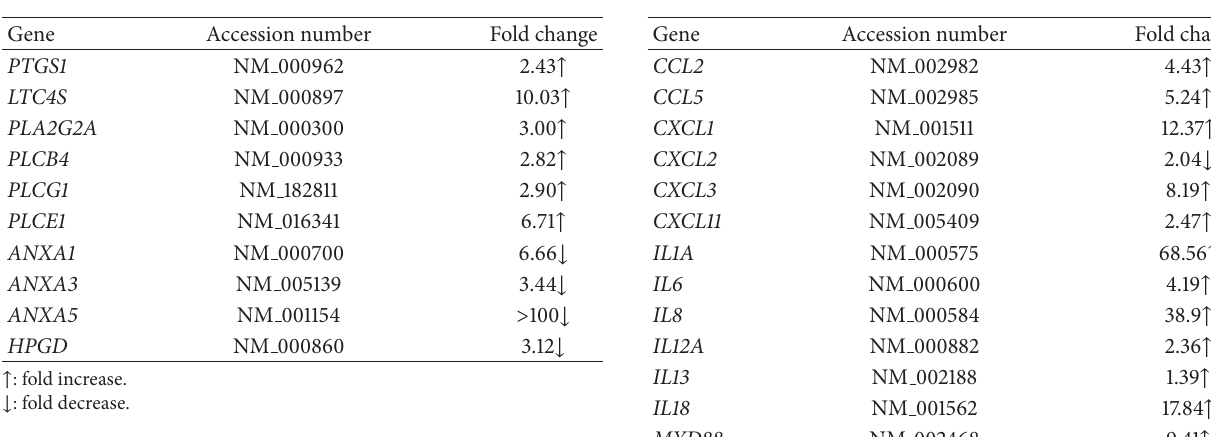
Table 1: Components of eicosanoid signalling regulated by SF in the Taqman 96-well plate array. Results are expressed as fold above control.